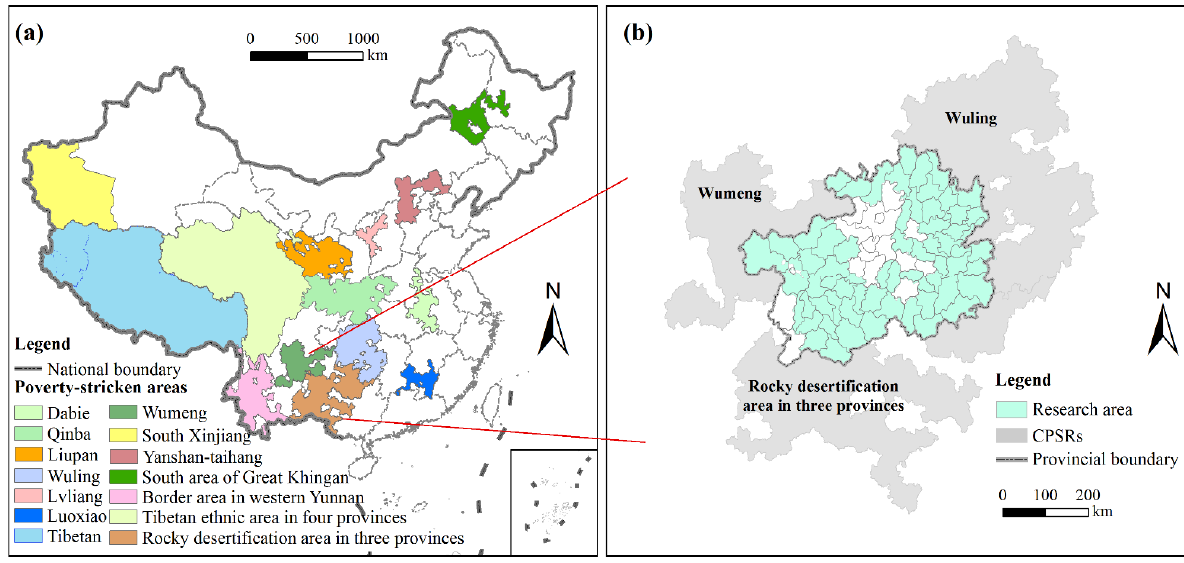
Figure 1. Location of the study area. ( a ) Spatial distribution of poverty-stricken areas. ( b ) Location of Guizhou Province and its neighboring poverty-stricken areas.